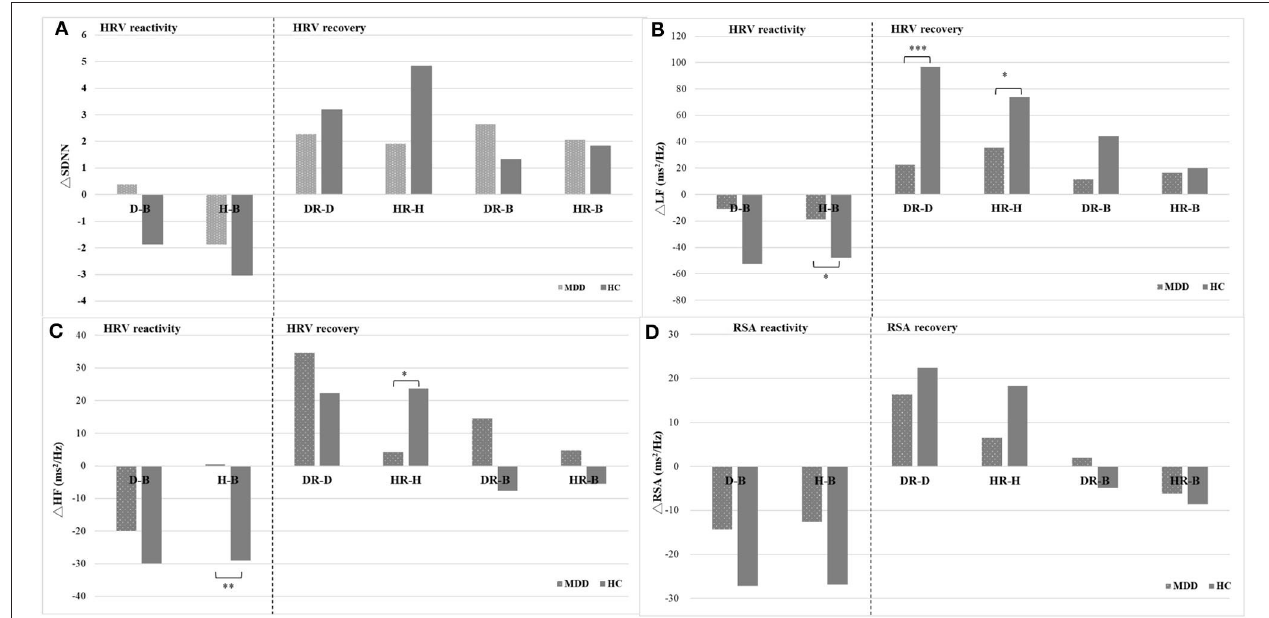
FIGURE 3 | The reactivity and recovery of cardiac autonomic (A–C) and CVC (D) for the MDD and HC groups. B, baseline; D, depressive autobiographical memory; DR, depressive recovery; H, happiness autobiographical memory; HR, happiness recovery.